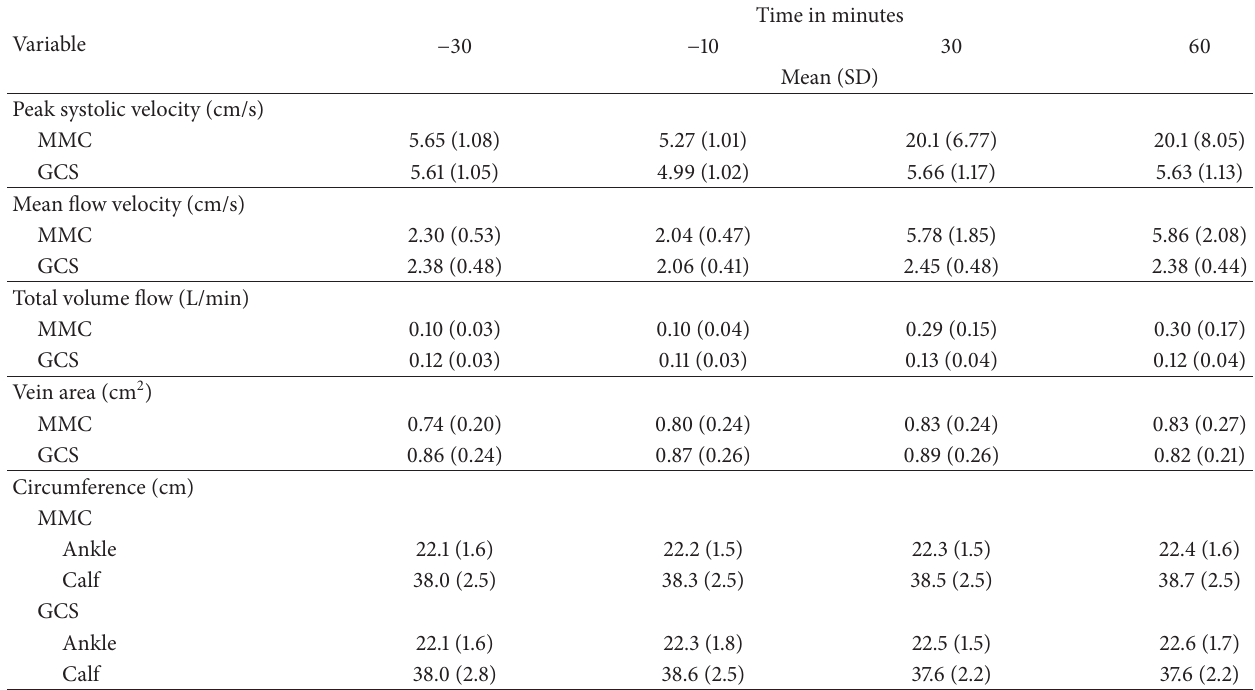
Table 3: Participant subjective feedback responses.